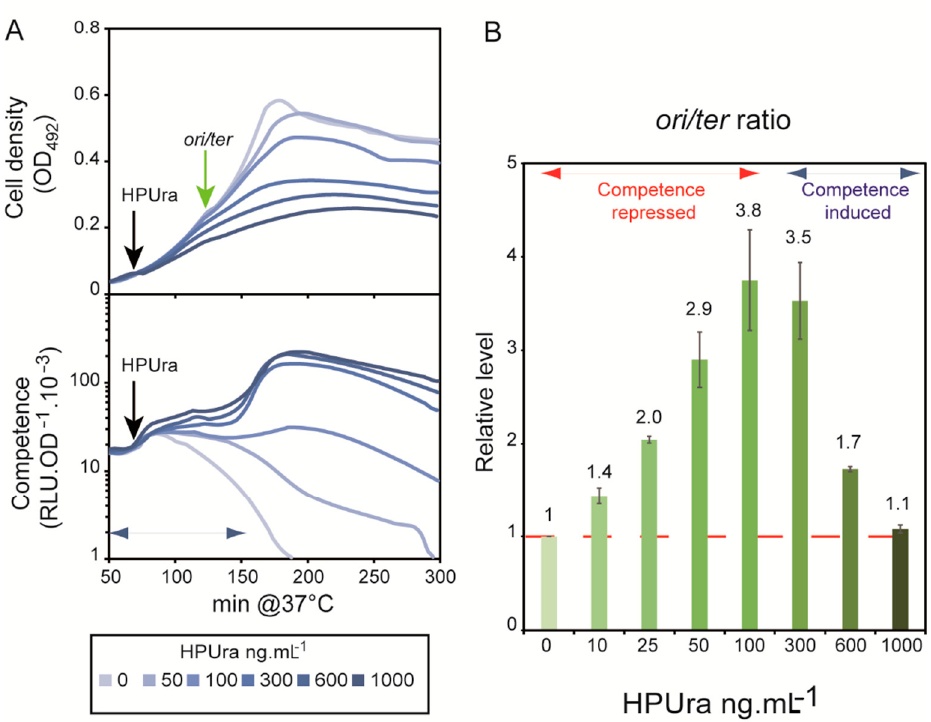
Figure 3. HPUra induces competence independently of its effect on the ori / ter ratio. ( A ): R895 cells were grown at a pH non-permissive for spontaneous development of competence. After 70 min of growth, HPUra was added at 0, 50, 100, 300, 600, and 1000 ng mL − 1 , light grey-blue to dark grey-blue, respectively. Cell density and competence plots are as in Figure 2. Curves represent the mean of three replicates for each condition. Standard deviations are omitted for clarity. ( B ): ori / ter ratios measured by qPCR on total DNA extracted from the WT R825 strain 1 h after HPUra addition at 0, 10, 25, 50, 100, 300, 600, and 1000 ng mL − 1 (shown as light green to dark green respectively; see also Figure S1). The ori / ter ratio obtained for cells grown without HPUra was set to 1 and used as the reference for ori / ter ratios of cells at each HPUra concentration. The competence development status of each assay is indicated by the blue (induced) and red (basal level) double arrowheads. The means and standard deviations were derived from two replicates.